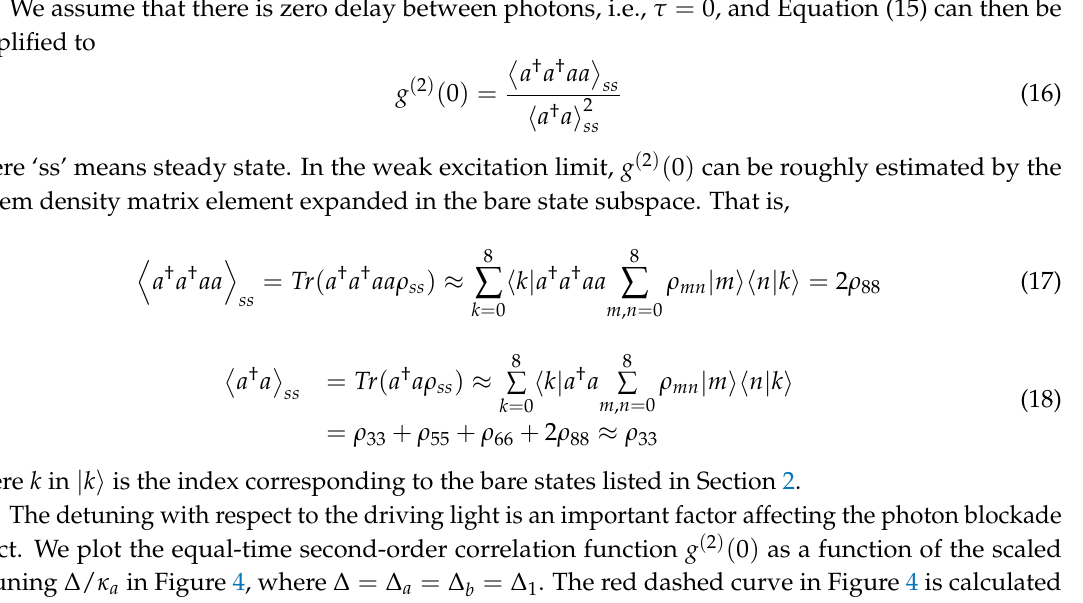
Figure 3. Time evolution of the average photon numbers in Cavity A in unit of 2 π / κ a . The parameters are κ b = κ a , γ = 0.6 κ a , ∆ a = 7 κ a , ∆ a = ∆ b = ∆ 1 , ε = 0.5 κ a , J = 9 κ a , g = 2 κ a , and n tha = n thb = n th 1 =